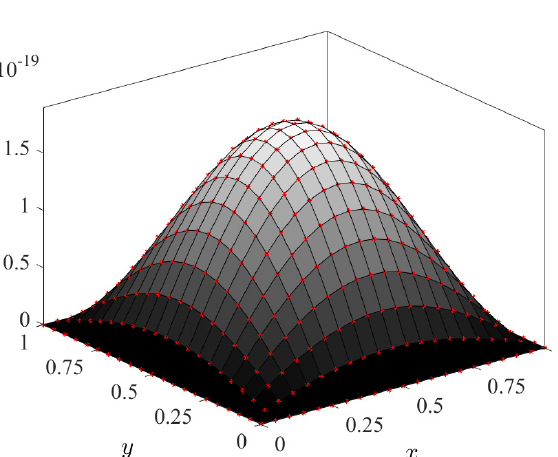
( b ) Figure 5. The analytical ( a ) and numerical ( b ) solutions with for 1 z = at 1 t = . Table 3. Comparison between the present method and existing methods with h = 0.1 and 0.01 t Δ = at different values of t for Example 2. t